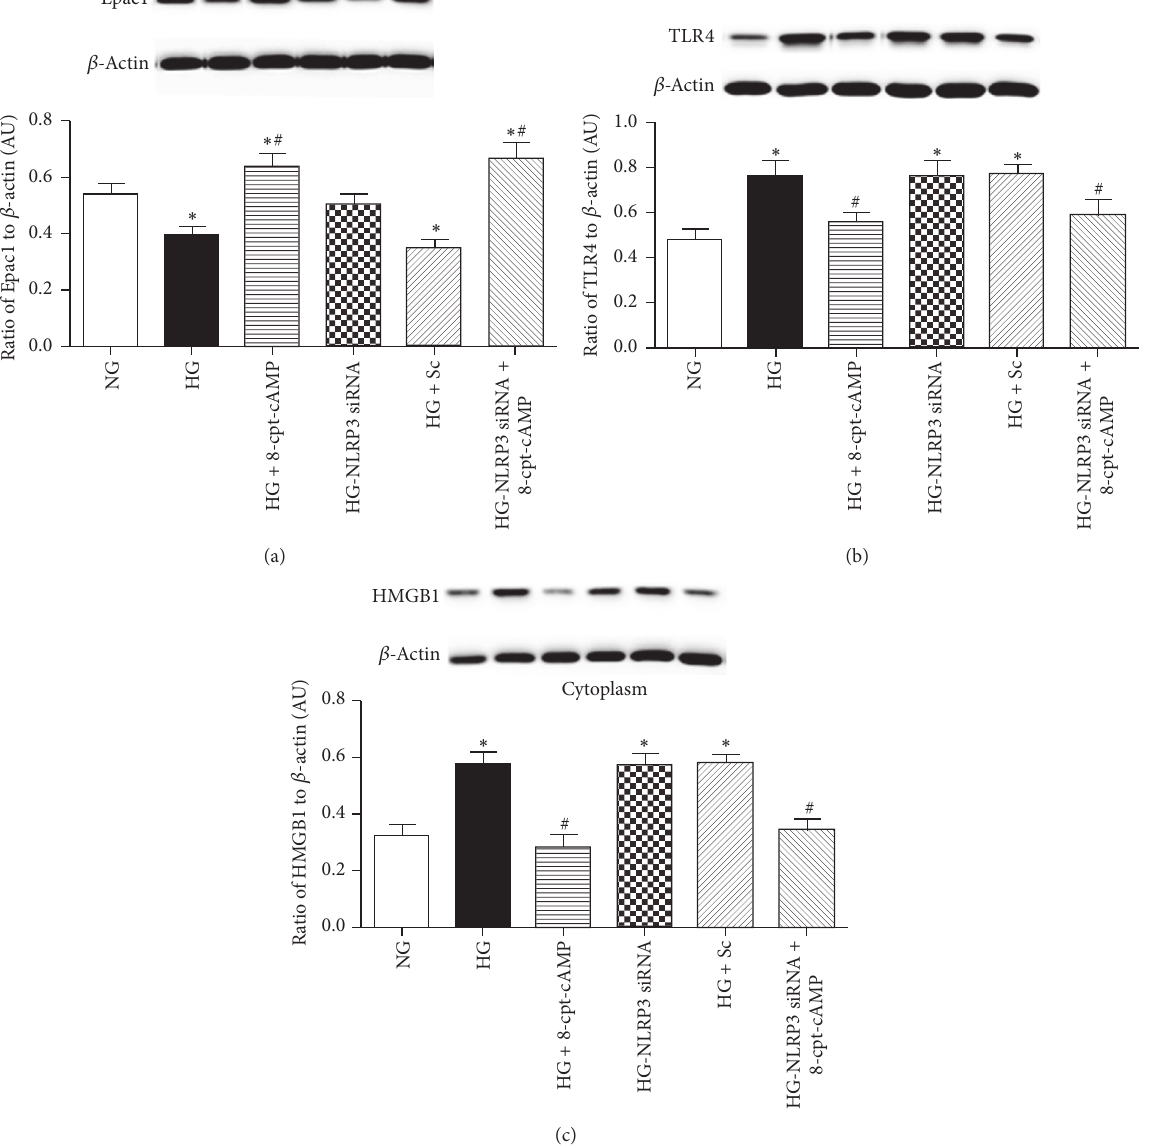
Figure 3: NLRP3 siRNA does not affect TLR4 and HMGB1 levels after Epac1 agonist treatment. Western blot data from REC grown in normal glucose (NG), high glucose (HG), high glucose + Epac1 agonist (HG + 8-cpt-cAMP), high glucose + NLPR3 siRNA (HG + NLPR3 siRNA), high glucose + scrambled siRNA (HG + Sc), and high glucose + Epac1 +NLRP3 siRNA (HG + NLRP3 siRNA + 8-cpt-cAMP) for Epac1 (a), TLR4 (b), and cytosolic HMGB1 (c). 𝑁 = 6 . Data are mean ± SEM. ∗ 𝑃 < 0.05 versus NG; # 𝑃 < 0.05 versus